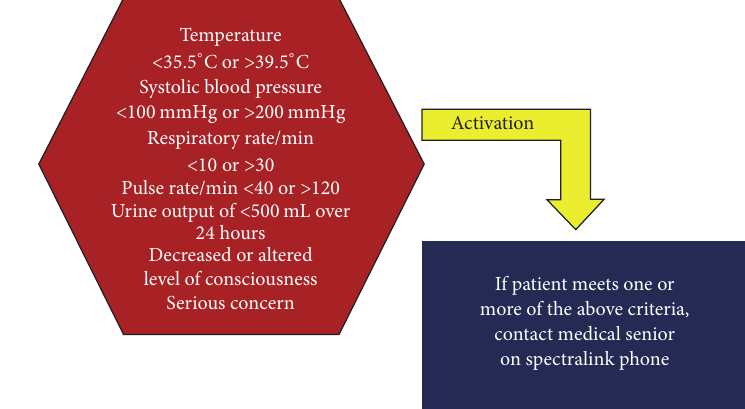
Figure 1: System activation criteria.